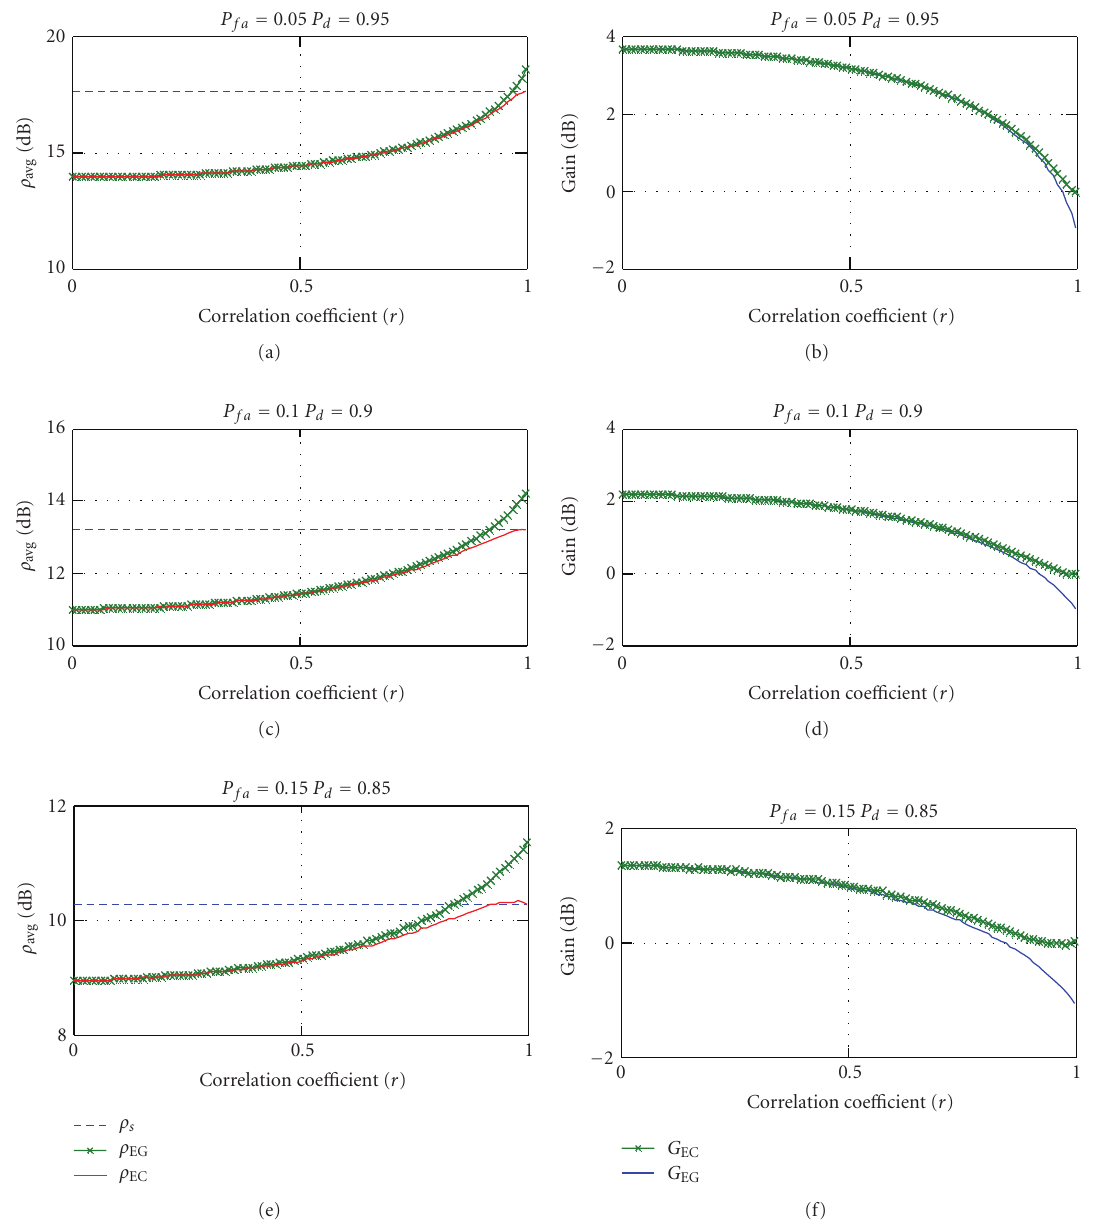
Figure 3: (a), (c), and (e) required SNR for the stationary and synthetic antenna with EC and EG for target values of P fa and P d ; (b), (d), and (f) processing gain of synthetic array with EC and EG